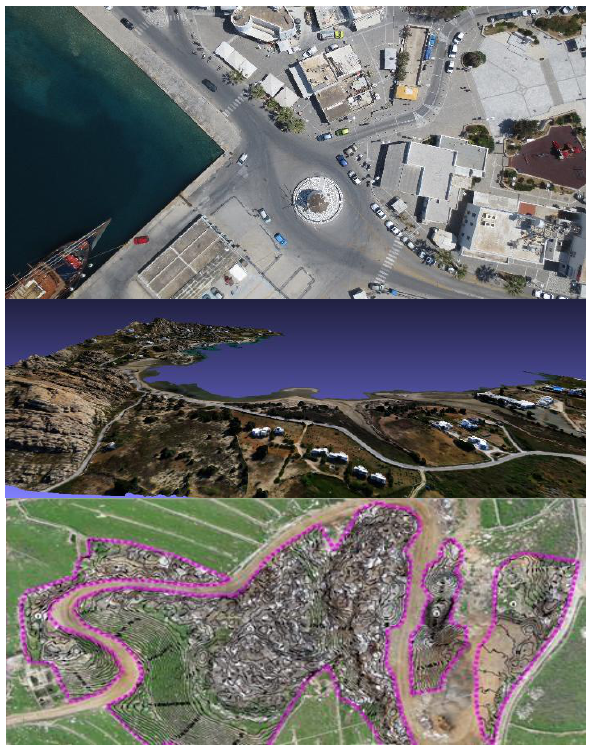
Figure 5: Drone’s data for the municipal proposal preparation concerning the municipal GIS and smart